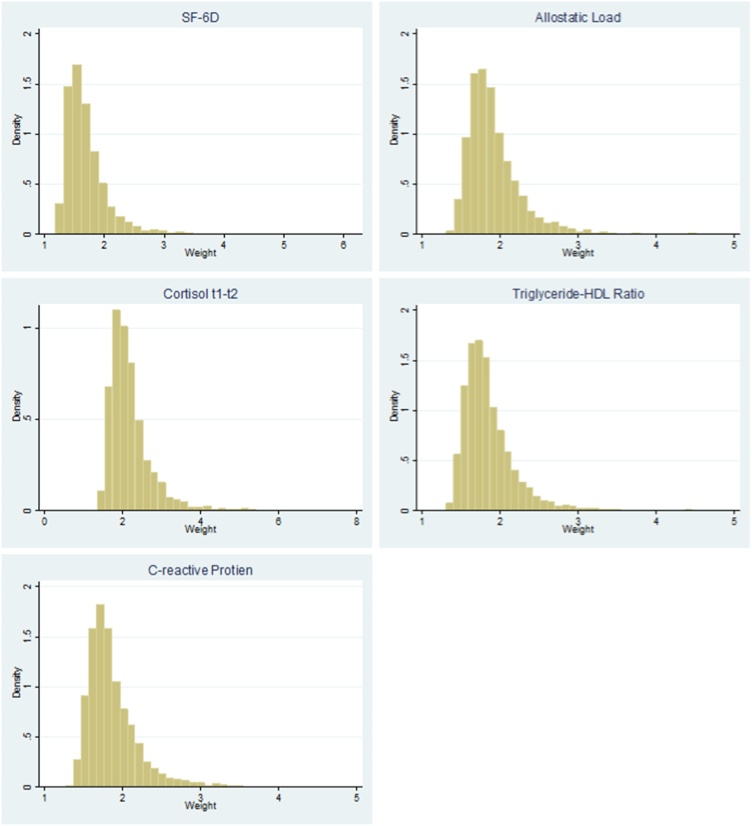
Distributions of inverse probability weights.